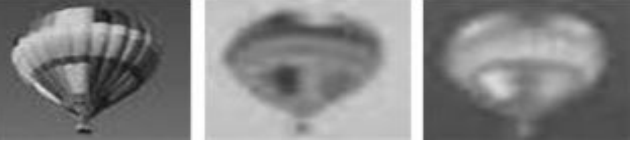
Figure 5. Luminance/chrominance components of original image.